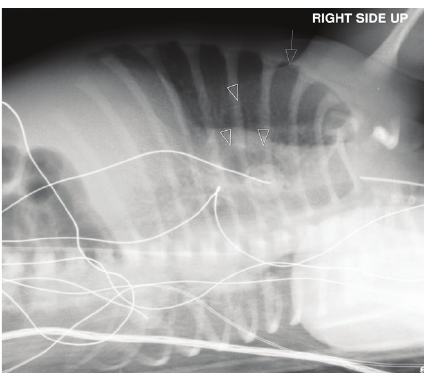
Figure 3: Left lateral decubitus view shows small pneumothorax (arrow) and enlargement of air-containing structures within the right lung (arrowhead).